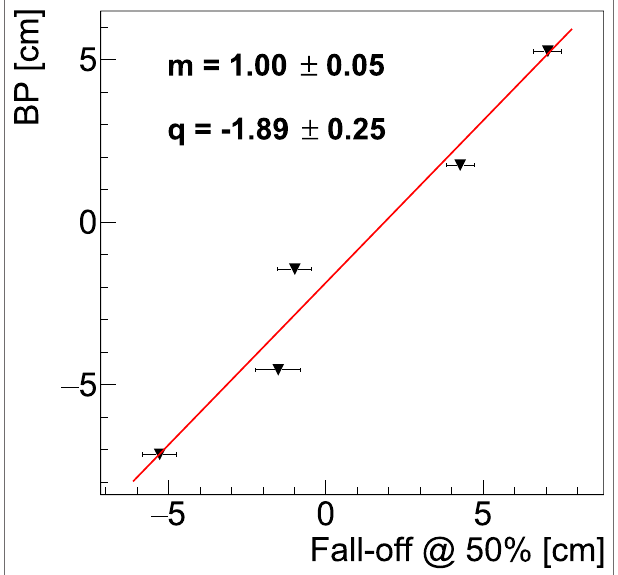
FIGURE 15 | True (black solid line) and unfolded (red triangles) distributions for a number of 1000 photons reconstructed exploiting the 160 MeV proton simulation. The true spectrum has been normalized to the maximum of the unfolded one. The errors on the unfolded distribution are statistical errors, due to the unfolding procedure. The solid line is the Fermi-Dirac fi t function reported in Eq. 2